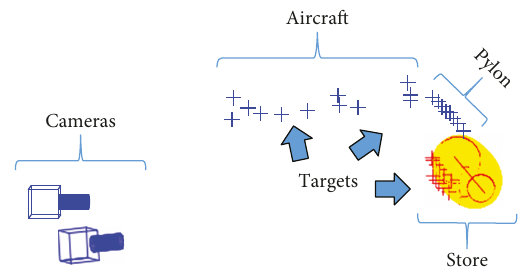
Figure 6: 3D representation of the camera in relation to the targets.